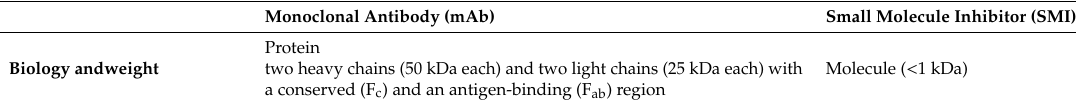
Table 2. Molecular principles for targeted therapies